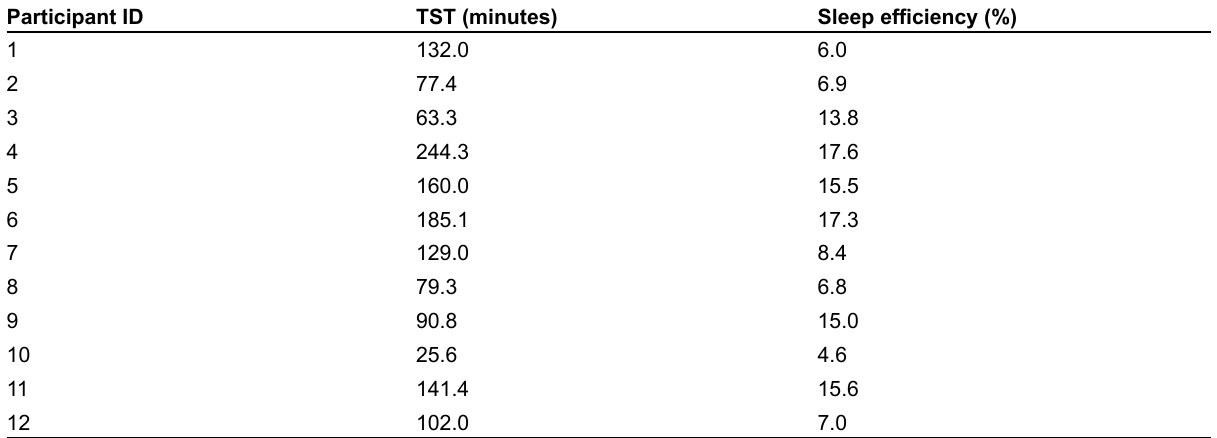
Table 2. Overestimation averages of TST (minutes) and sleep efficiency (%) by participant